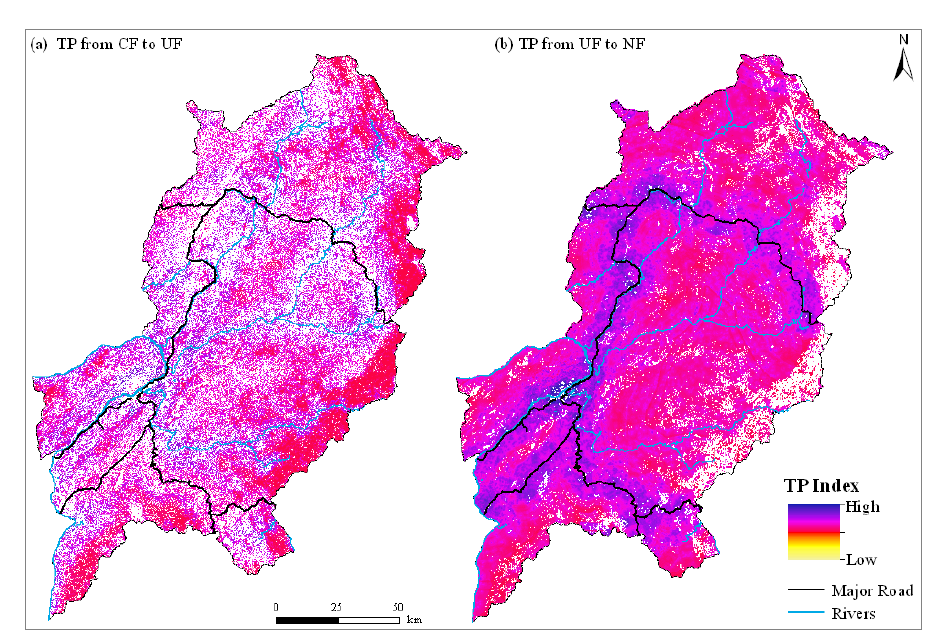
Figure 4. Transition potential (TP) maps: ( a ) “current forest (CF) to unstocked forest (UF)”, and (b ) “unstocked forest (UF) to non-forest